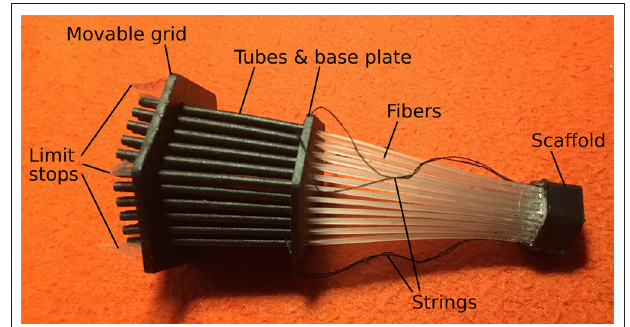
FIGURE 10 | Completely assembled prototype 2 with 3D-printed parts and 91 fibers. The object side is left and the image side at the scaffold is right. The whole device is ∼ 120 mm long.